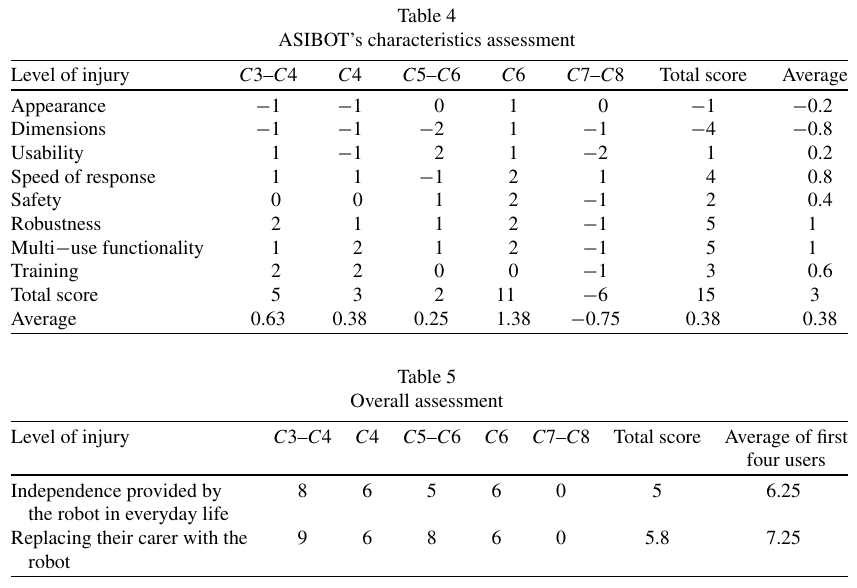
Level of injury